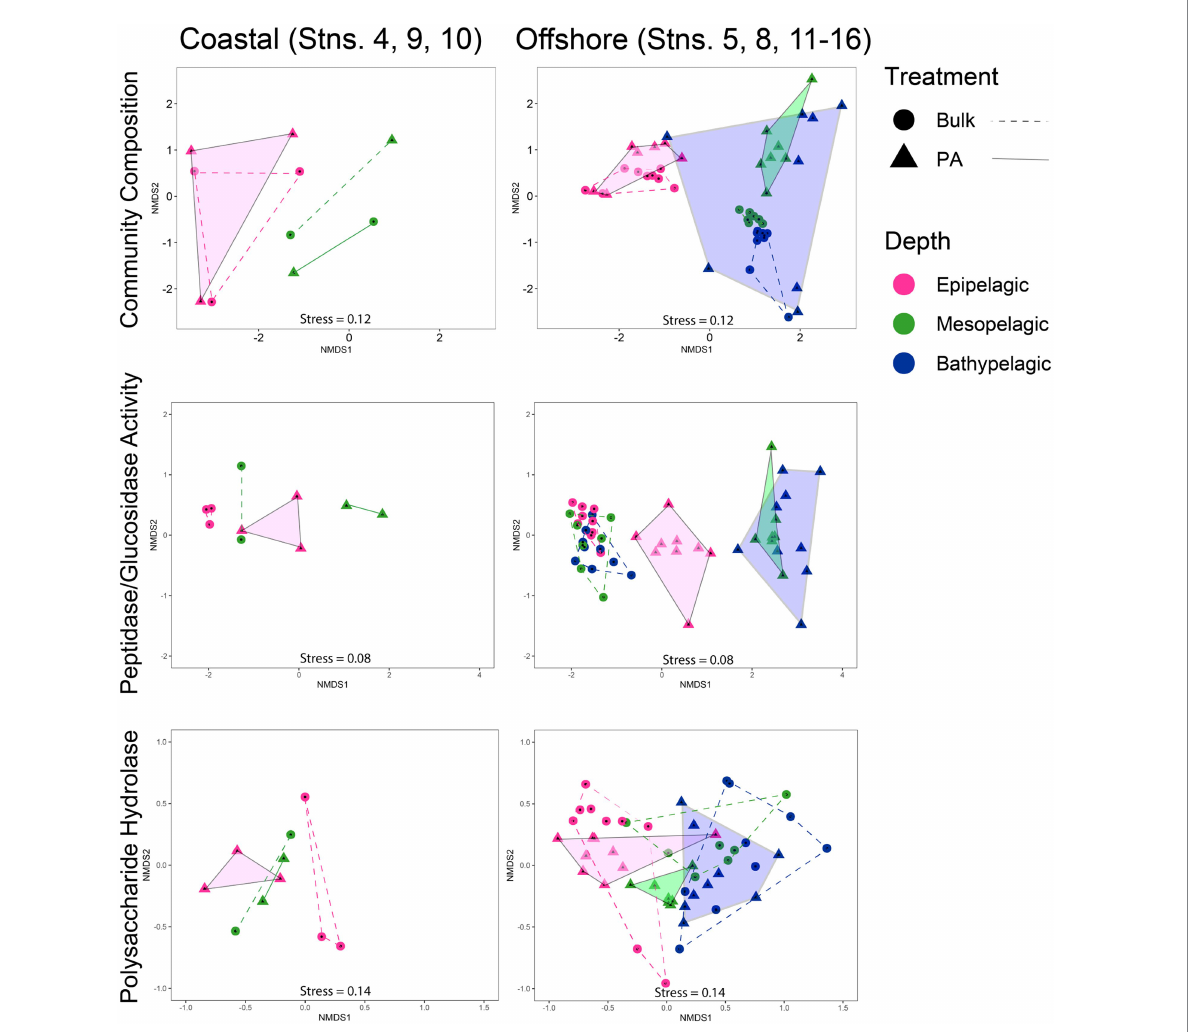
FIGURE 6 Non-metric multidimensional scaling (NMDS) of community composition, glucosidase and peptidase activities, and polysaccharide hydrolase activities, separated into coastal and offshore stations using Bray–Curtis dissimilarity index. PA data are represented by triangles and are outlined and shaded; bulk data are represented by circles and are outlined with a dashed